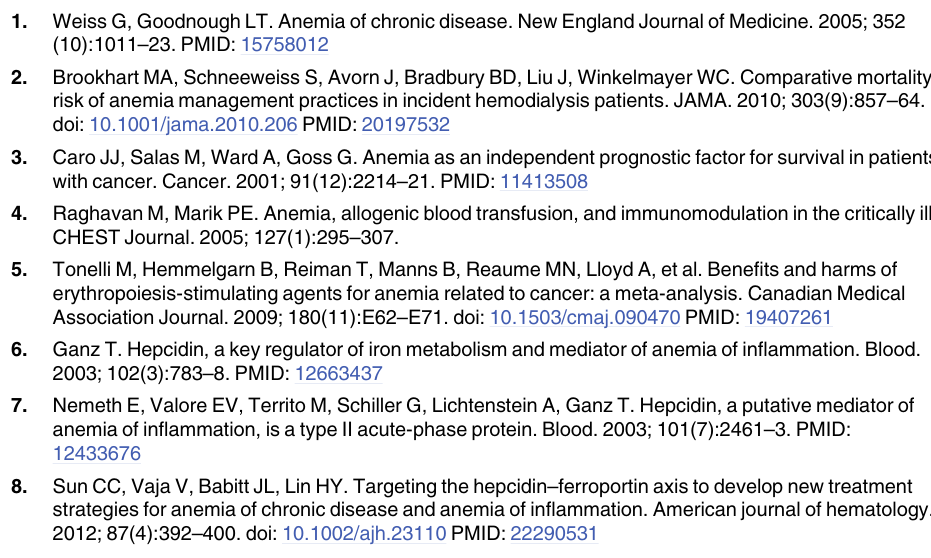
S2 Fig. Whole uncropped images of the original western blots for Fig 4C. Whole uncropped images of the original western blots for p-JAK2 (A), JAK2 (B, ten lanes from the right are used), p-STAT3 (C), STAT3 (D), and GAPDH (E) in Fig